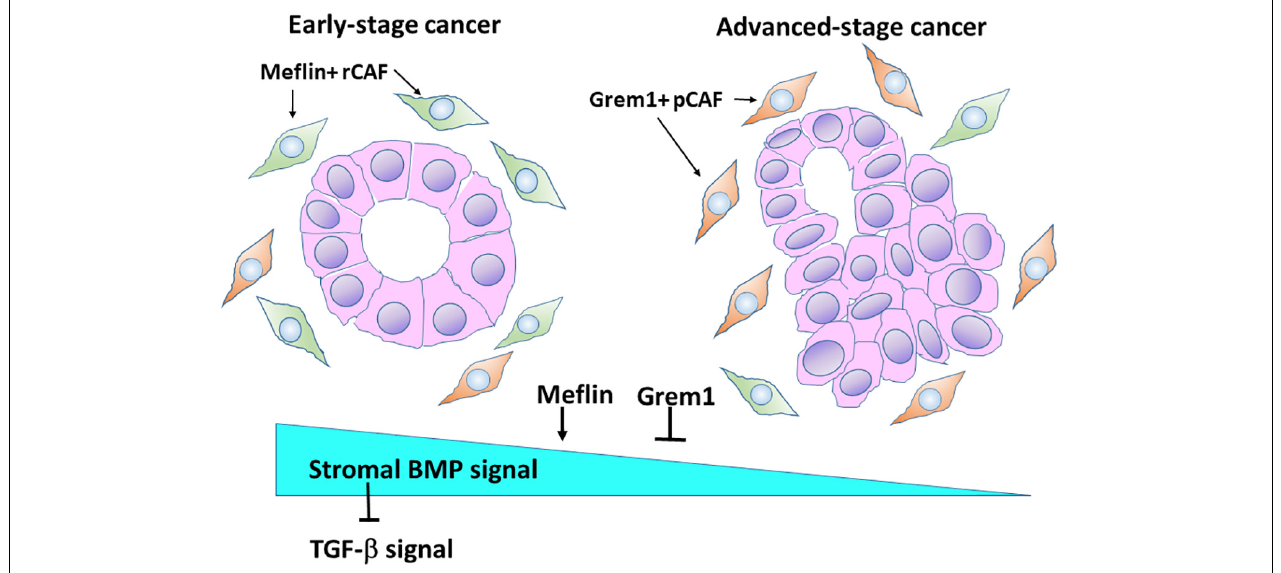
FIGURE 3 | Meflin and Grem1 expression in CAFs regulates stromal BMP signalling involved in tumour progression. The collective evidence from several studies shows that Meflin + rCAFs proliferate in early-stage cancer, in which Meflin may augment stromal BMP signalling that counteracts with TGF- β signalling. In advanced-stage cancer, Grem1 + pCAFs may be dominant and suppress BMP signalling to promote cancer progression.